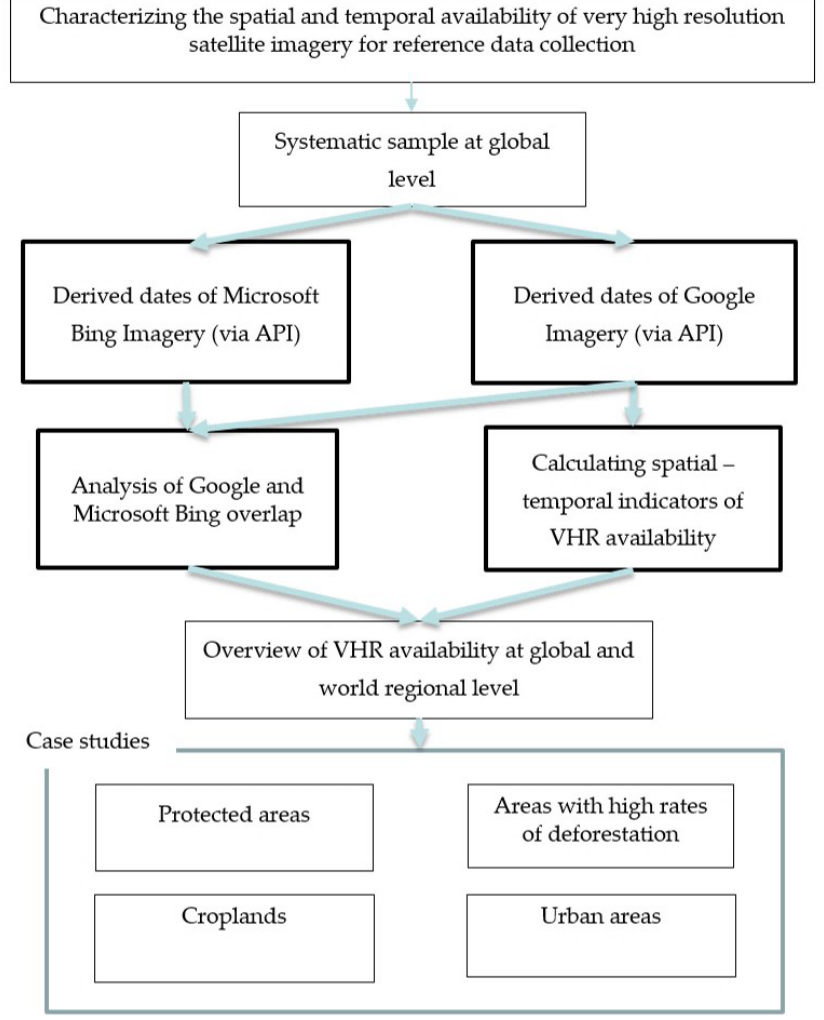
Figure 1. A summary of the methodology for the collection and analysis of imagery from Google Earth and Microsoft Bing